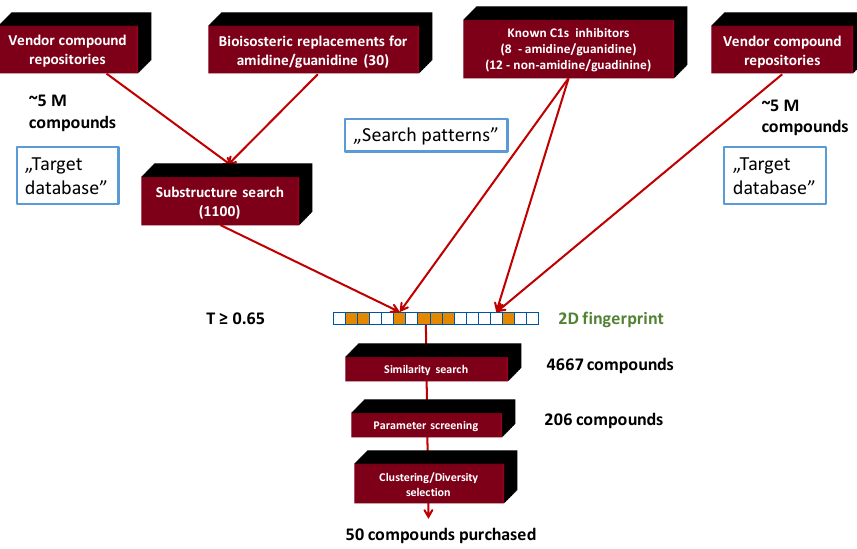
Scheme 2. Flow chart of the focused library generation by 2D similarity search .